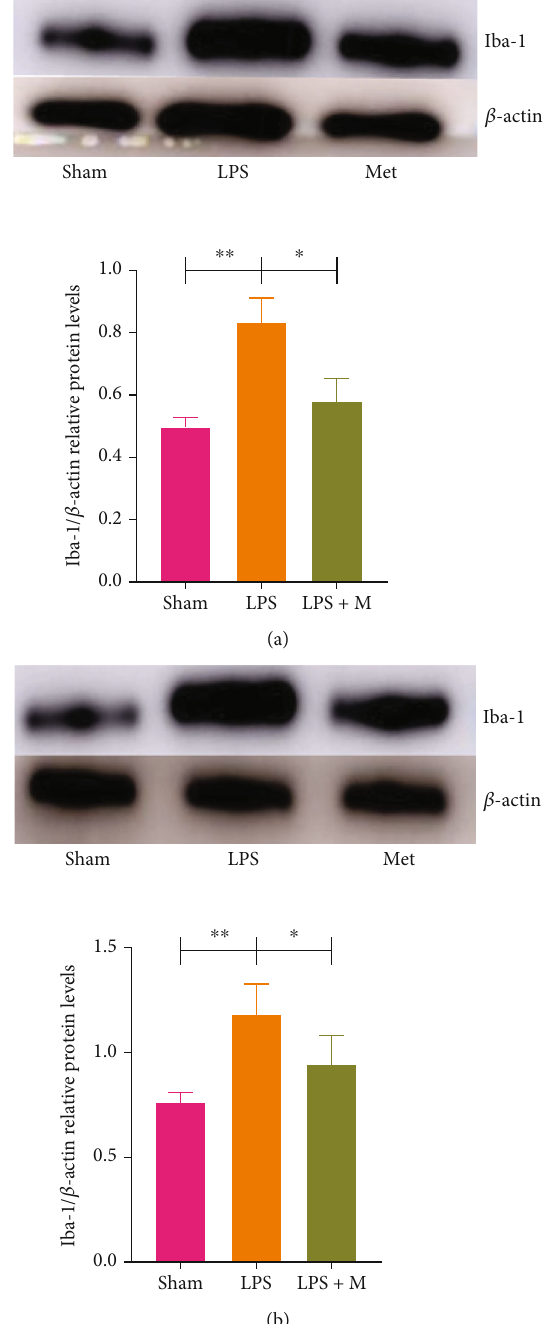
Figure 3: (a, b) E ff ect of metformin on the level of in fl ammatory factor protein in brain tissue of SAE-induced mice. In fi gures (a) and (b), the expression level of Iba-1 in LPS + M group was lower than that in LPS group, indicating that metformin could inhibit the activation of microglia. ∗ p < 0 : 05 , ∗∗ p < 0 : 01 , ∗∗∗ p < 0 : 001 . n = 10 in each group; Iba-1: ionized calcium-binding adapter molecule 1; LPS: lipopolysaccharide; LPS + M : lipopolysaccharide and